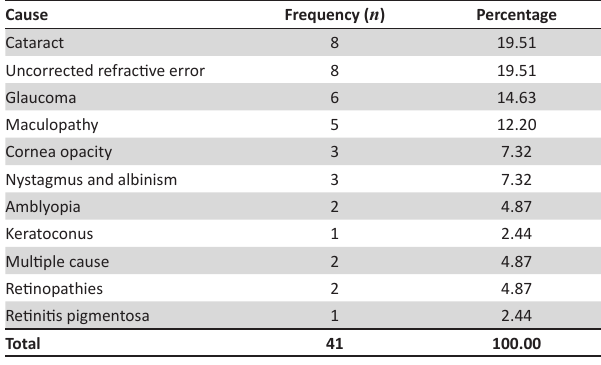
TABLE 2: Causes of low vision among cases ( n = 41).